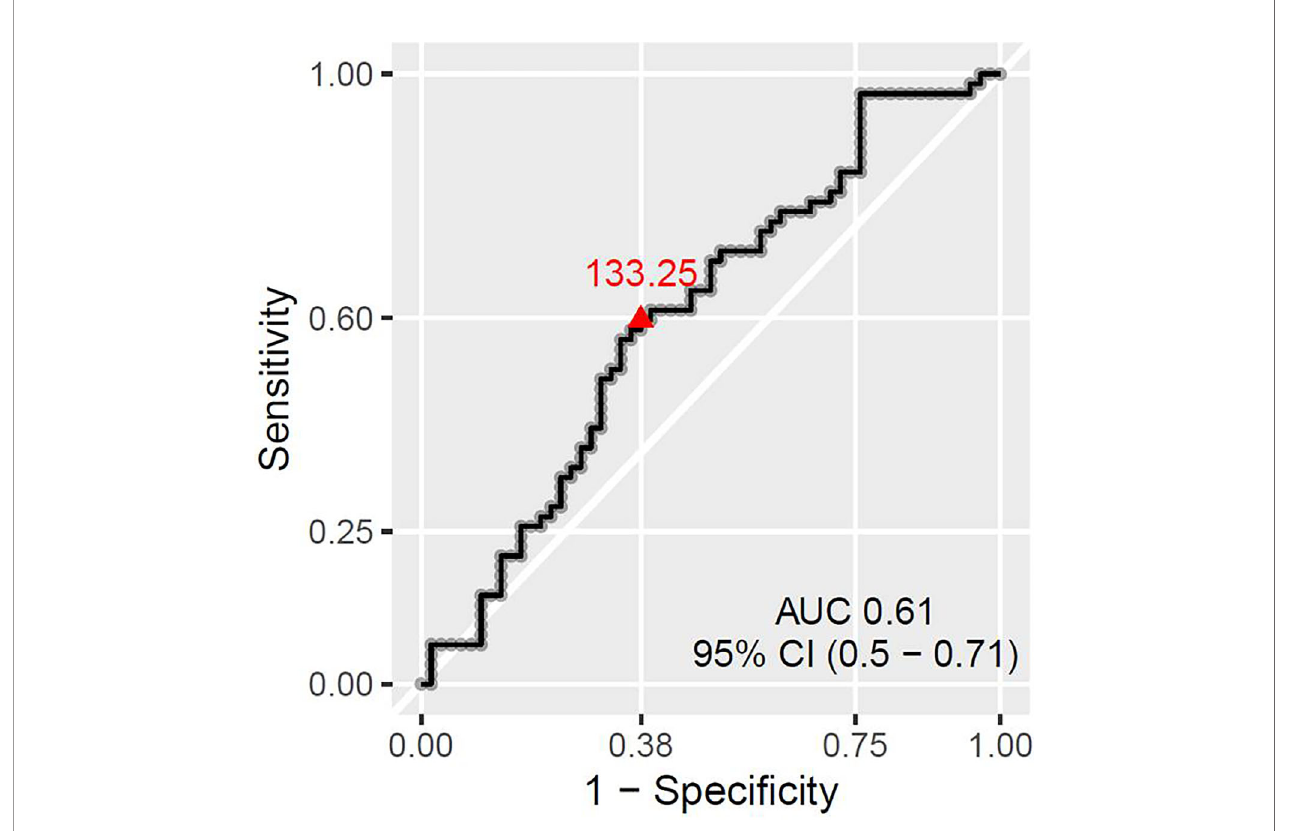
FIGURE 5 | ROC curve showing the best PLR cut-off for predicting patient chances to have absent or small residual